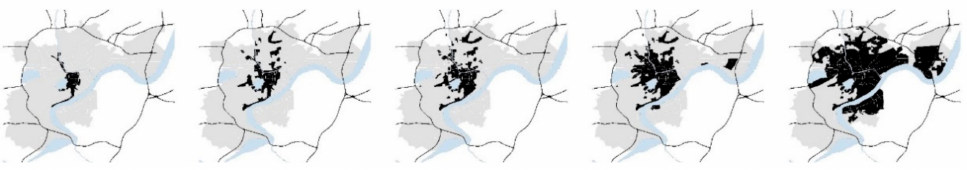
Figure 2. Built-up area of Hangzhou main city in 1949, 1965, 1981, 1996, and 2010.